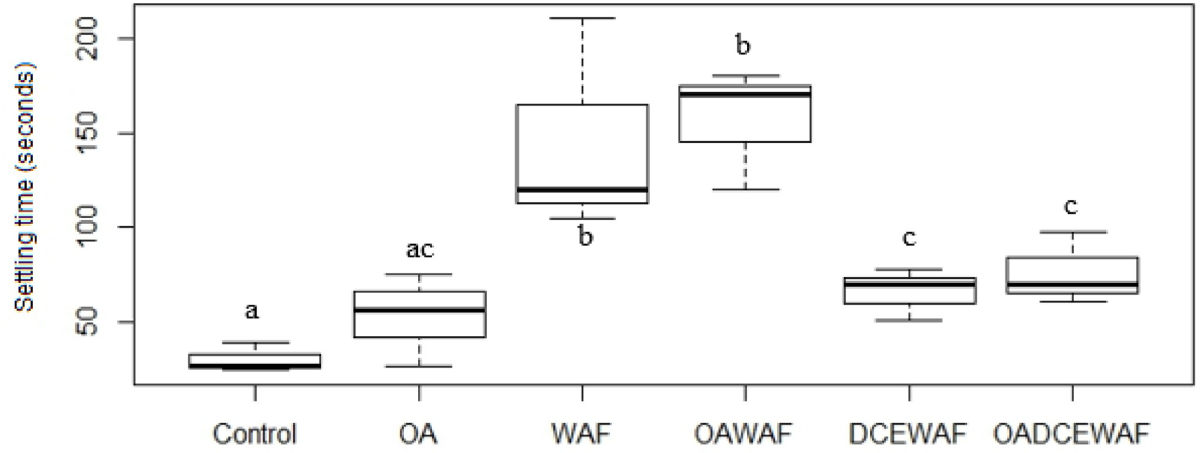
Fig 2. Settling time (sec) for all aggregates of T . pseudonana at the end of the roller table experiments. Box and whisker plots with mean values (dark bar) and error bars of the maximum and minimum values for replicates. Different letters indicate which treatments are significantly ( p < 0.05) different from each